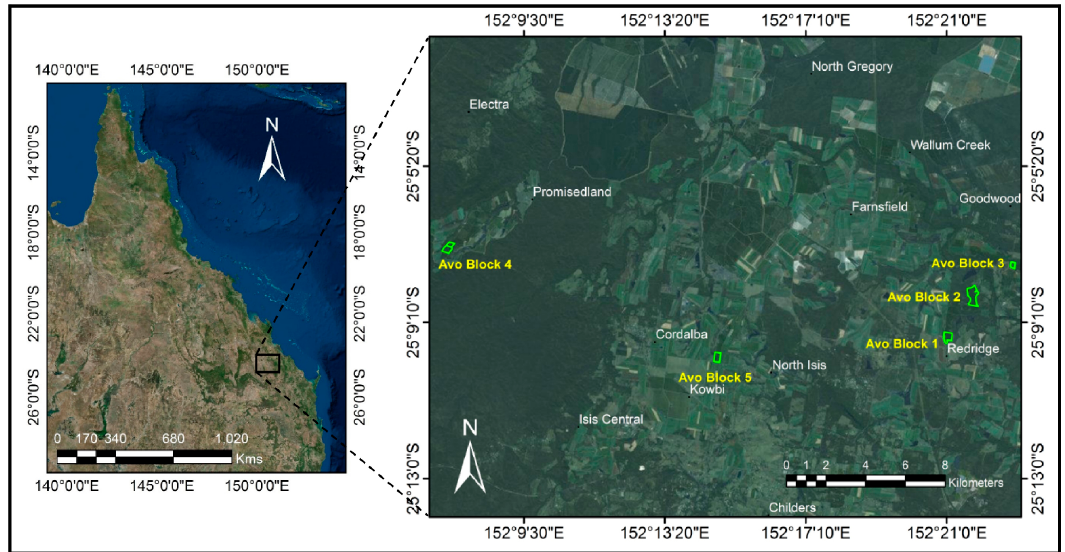
Figure 1. Location of the five avocado orchards in Bundaberg, Queensland, Australia (green polygons).